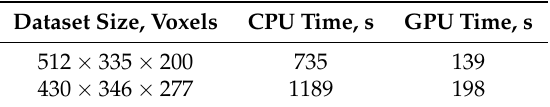
Table 1. Results of entropy feature computation for two Computed Tomography (CT) datasets: image dimensions and computation times for both Central Processing Unit (CPU) and Graphics Processing Unit (GPU) version of the program code.